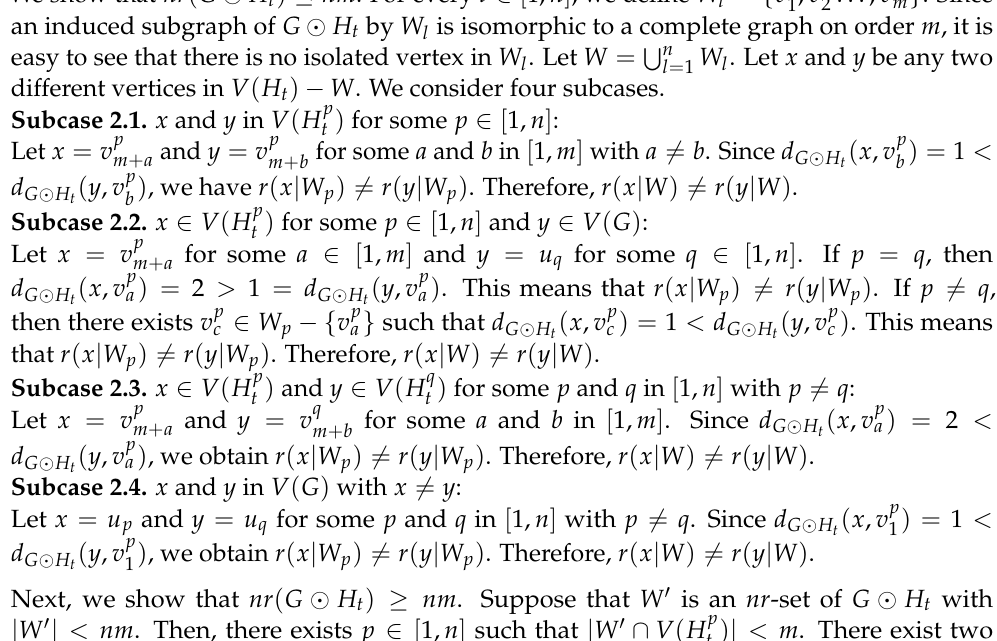
, v 1 , v 2 , v 2 , v 3 , v 3 2 2 2 1 1 1